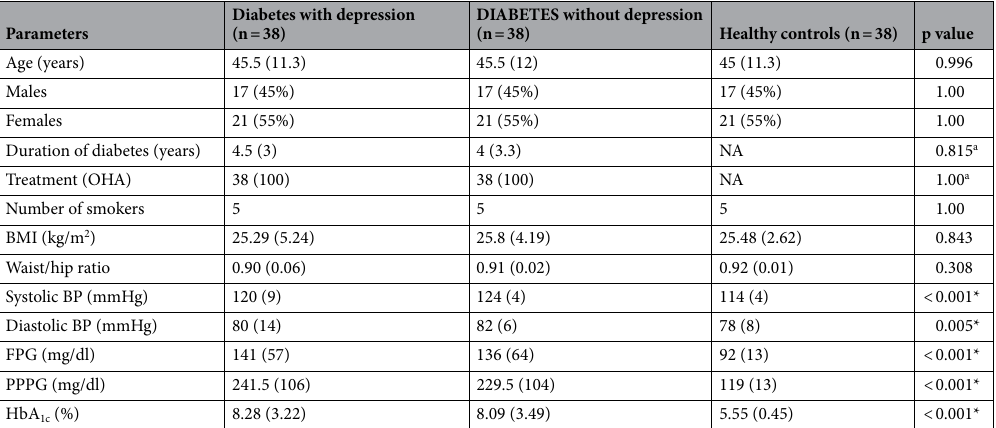
Table 1. Baseline characteristics of the study group. Results represented as Median (IQR) or Number of subjects (Percentage). BP blood pressure, OHA oral hypoglycemic agents, BMI body mass index, FPG fasting plasma glucose, PPPG post prandial plasma glucose, HbA 1c glycated hemoglobin. p value calculated by Kruskal–Wallis H test for continuous data and chi square test for categorical data. *p value < 0.05, shows statistically significant difference. a p value compared between participants with diabetes and depression and those without depression, as it was not applicable for healthy controls.